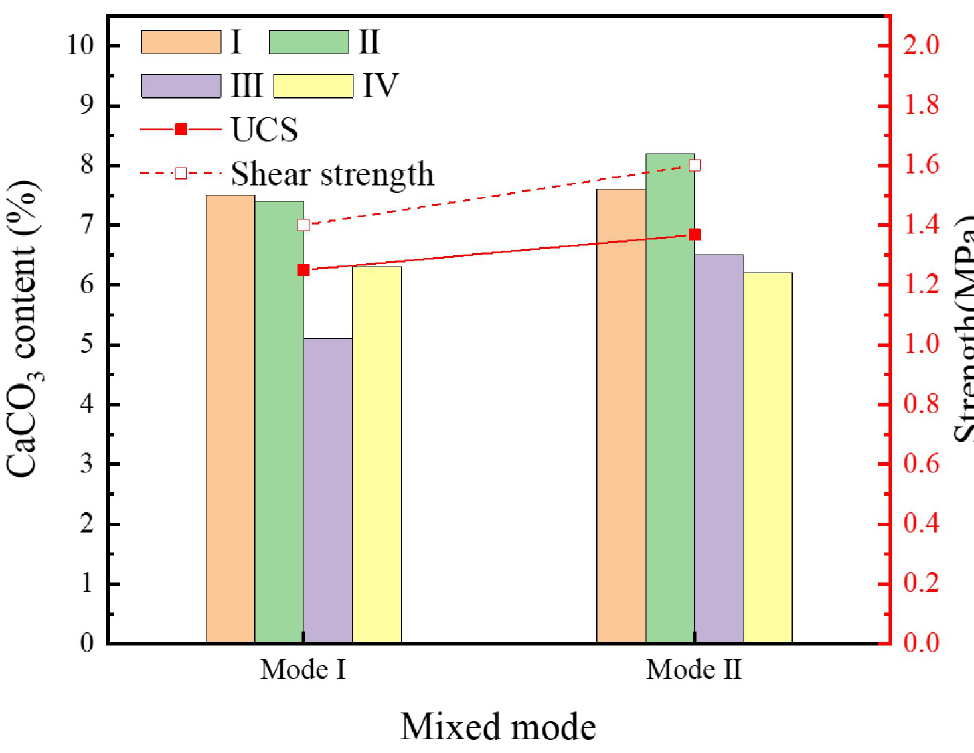
Fig 20. Cementation effect of different mixing